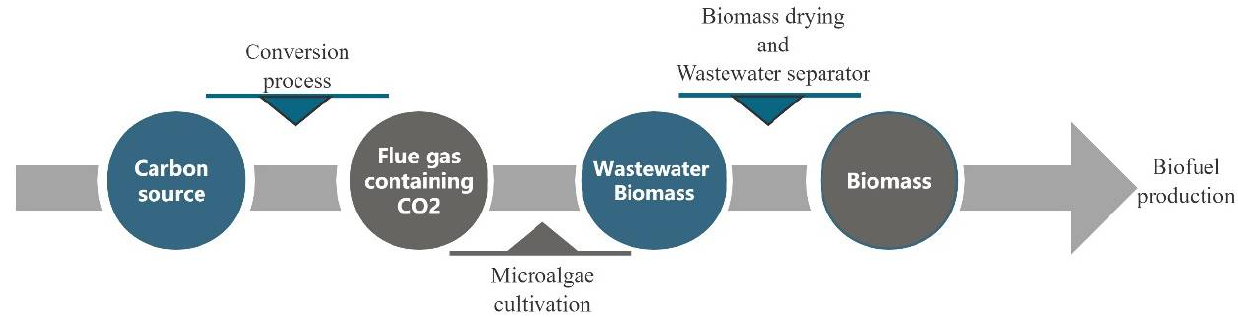
Figure 16. Biofuels from microalgae process. Adapted with permission from [136], Taylor & Francis, 2019.